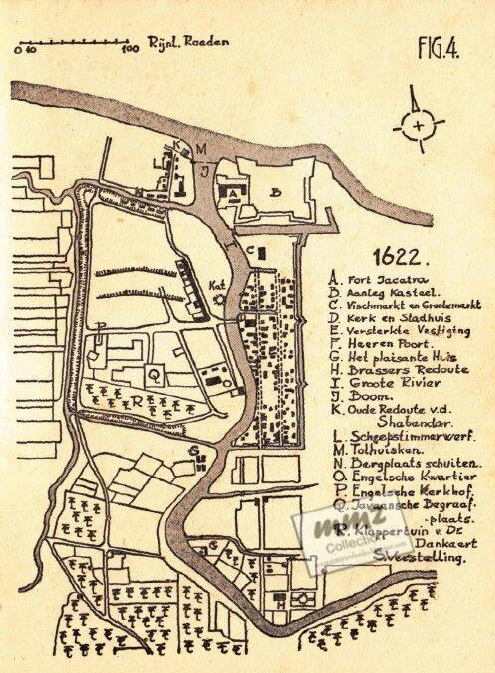
Figure 6. 1622 map shows stronger jurisdiction in the alignment of settlements and newly entrenched canals.